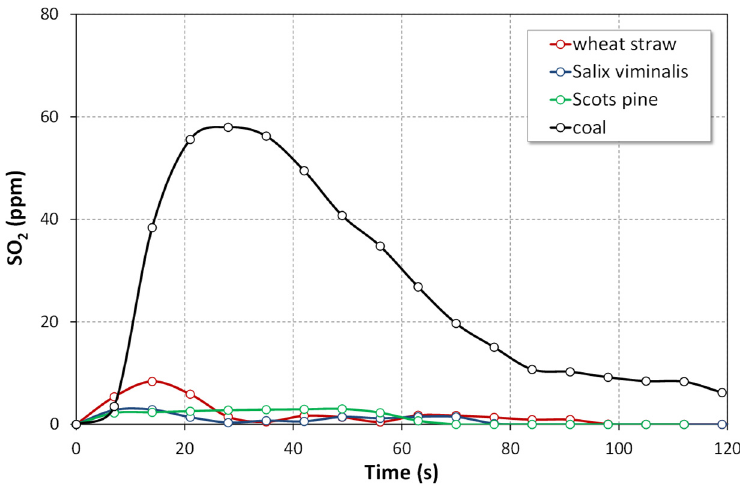
Figure 5. The instantaneous concentrations of SO 2 during air combustion.